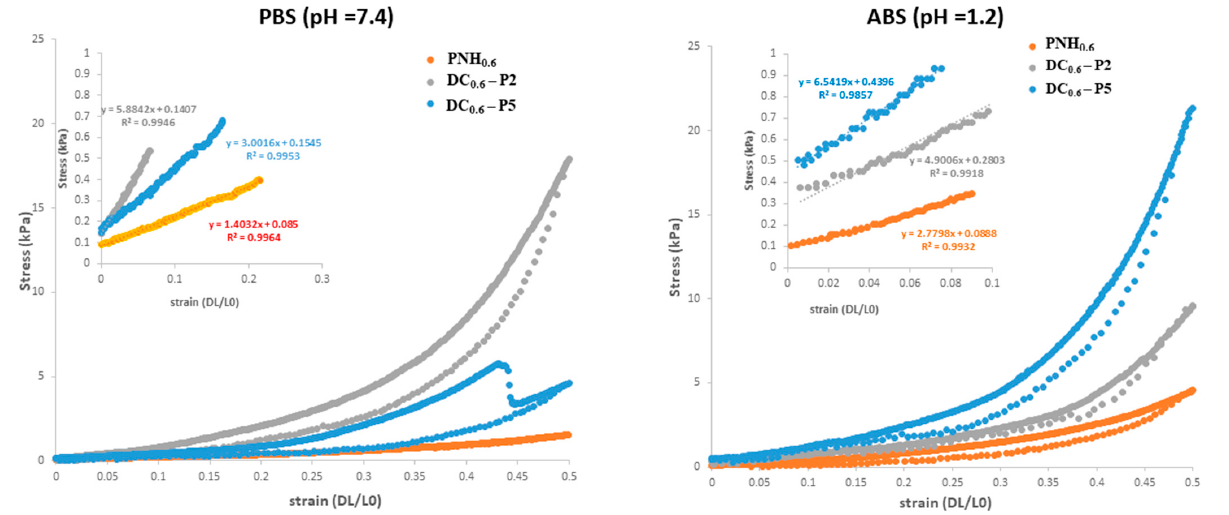
Figure 9. Stress–strain curves for conventional and double cross-linked hydrogels determined in simulated physiological conditions.